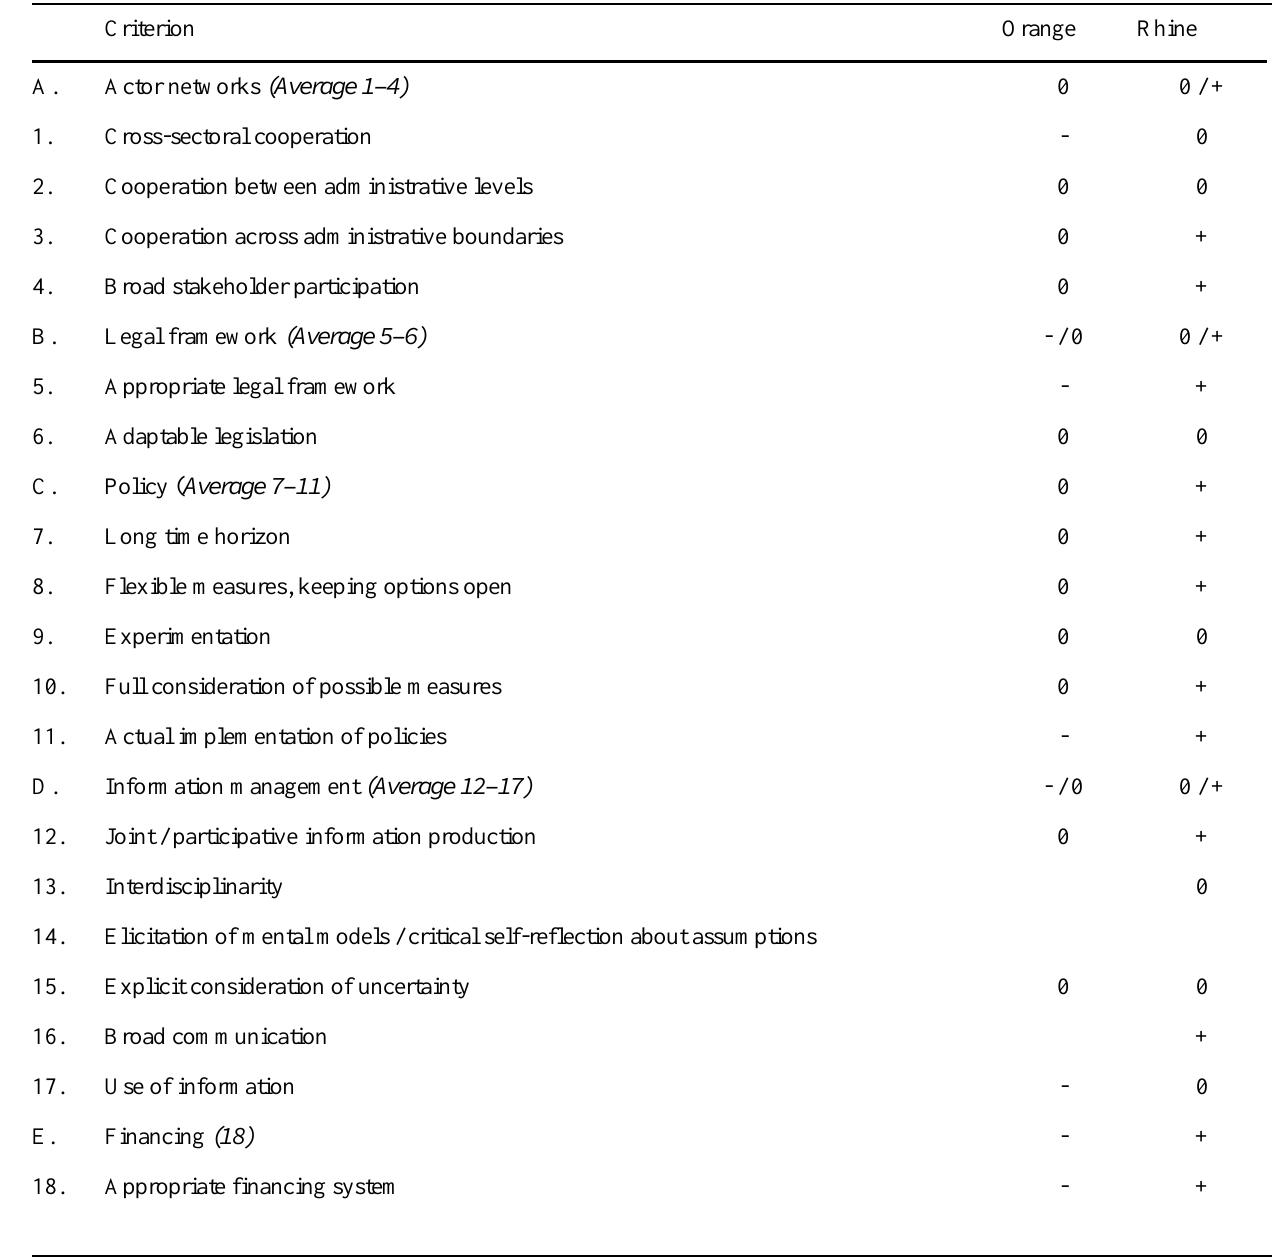
Table 3. Qualitative scores of basins on criteria for adaptive management (- = low, 0 = average, + = high) Criterion Orange